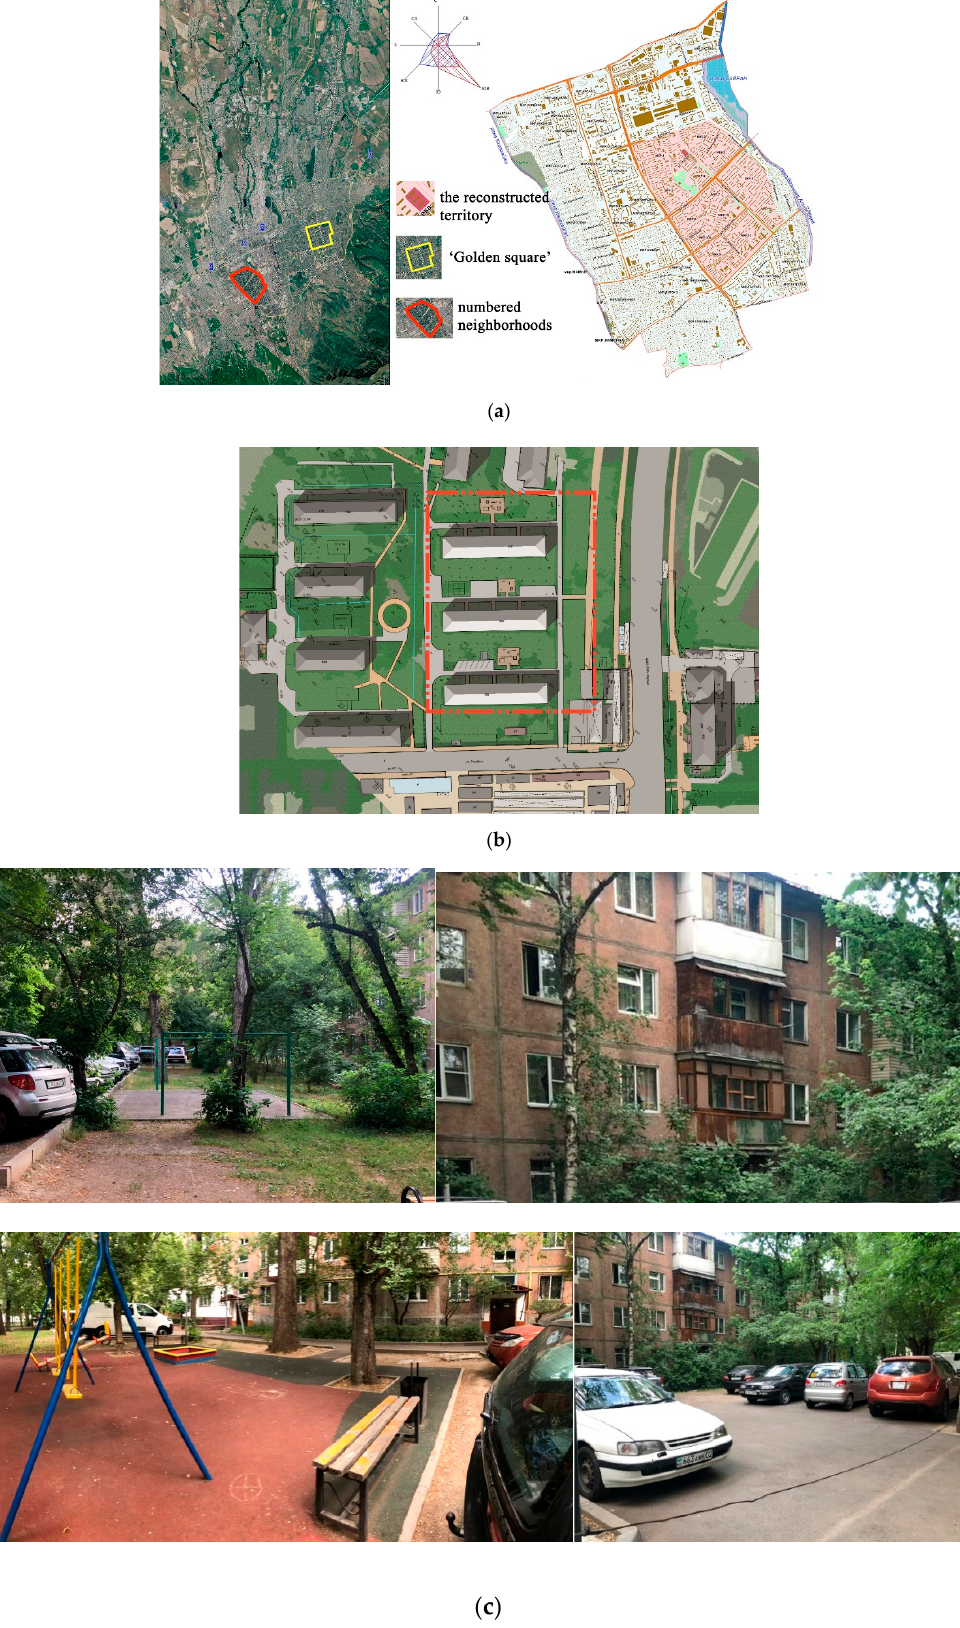
Figure 15. Initial data on the reconstructed territory—a fragment of microdistrict № 1 in Almaty: ( a ) Situational scheme. ( b ) Reference plan. ( c ) Photos of courtyard spaces (Author’s material). Table 1. Pre-project analysis.